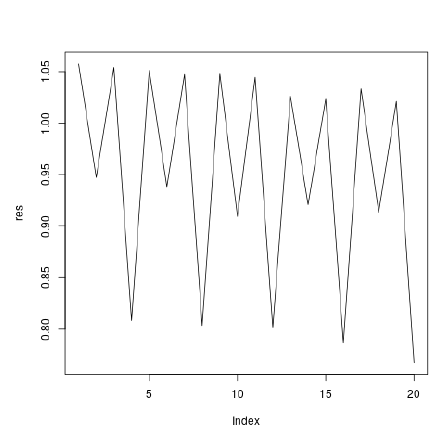
Figure 3: The empirical risk as a function of T